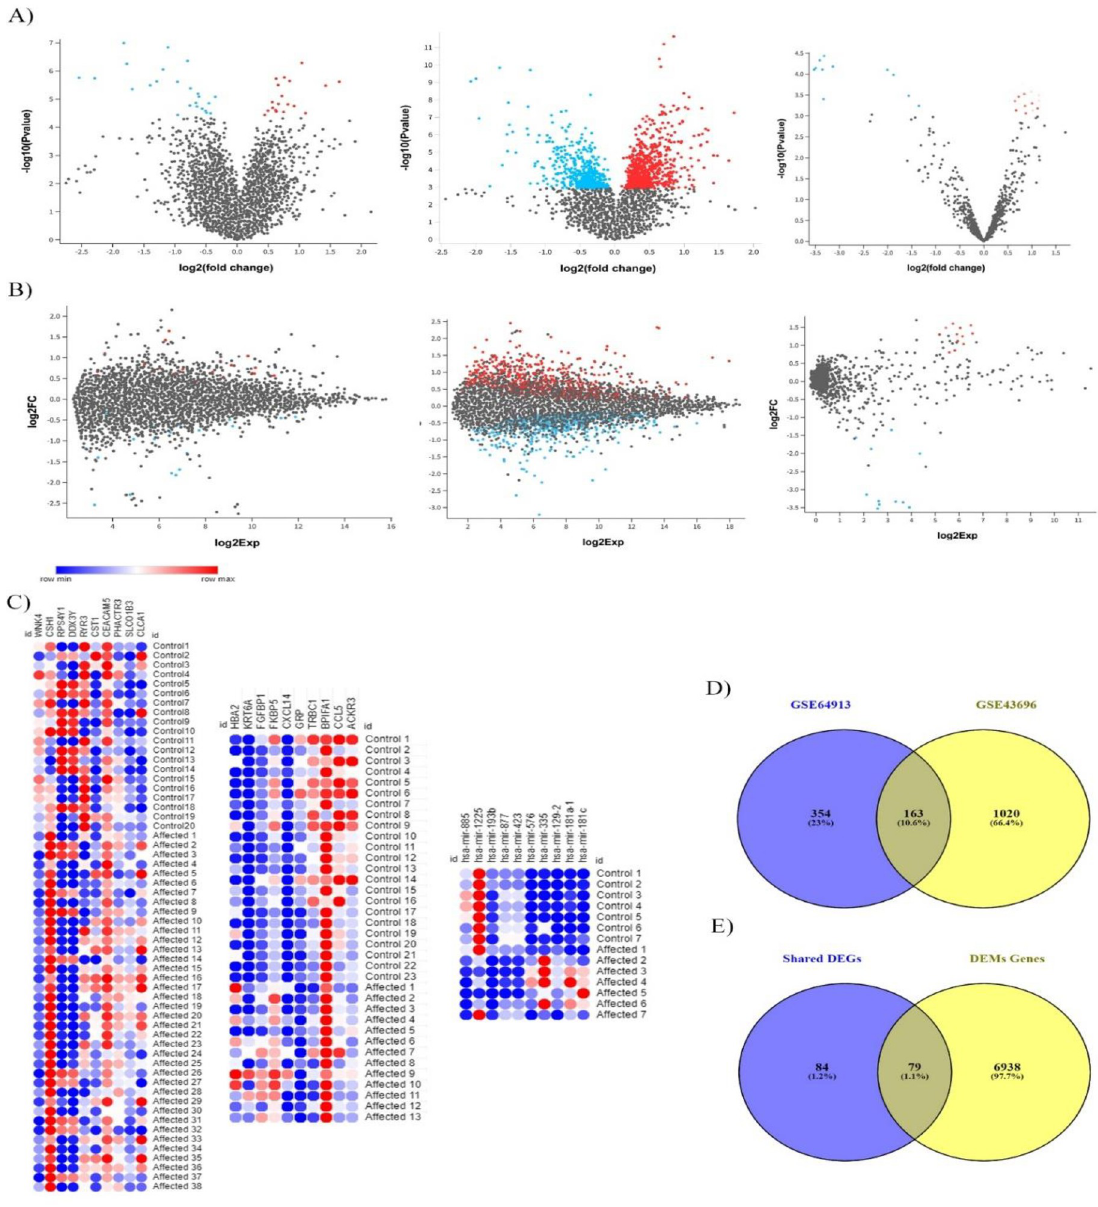
Fig 1. The mRNA and miRNA expression analysis of asthma patients. a) volcano plots for three differential gene expressions in 3 datasets (2mRNA and 1miRNA). Scattered points represent genes: the x-axis is the fold change for the ratio of control vs asthma, whereas the y-axis is the -log10 or P-value. Colored dots are the significantly differentially expressed genes. b) Mean difference (MD) plot showing log 2 -fold change versus average log 2 expression values of differentially expressed mRNA or miRNA (significantly expressed mRNA or miRNA highlighted with colored dots). c) Heat map of top significant expressed mRNA and miRNA represented by red and blue color, respectively; white color indicates the median level (Generated from https://software.broadinstitute.org/morpheus) d) Venn plot representing shared gene in two datasets (mRNA) and shared miRNA target genes from one